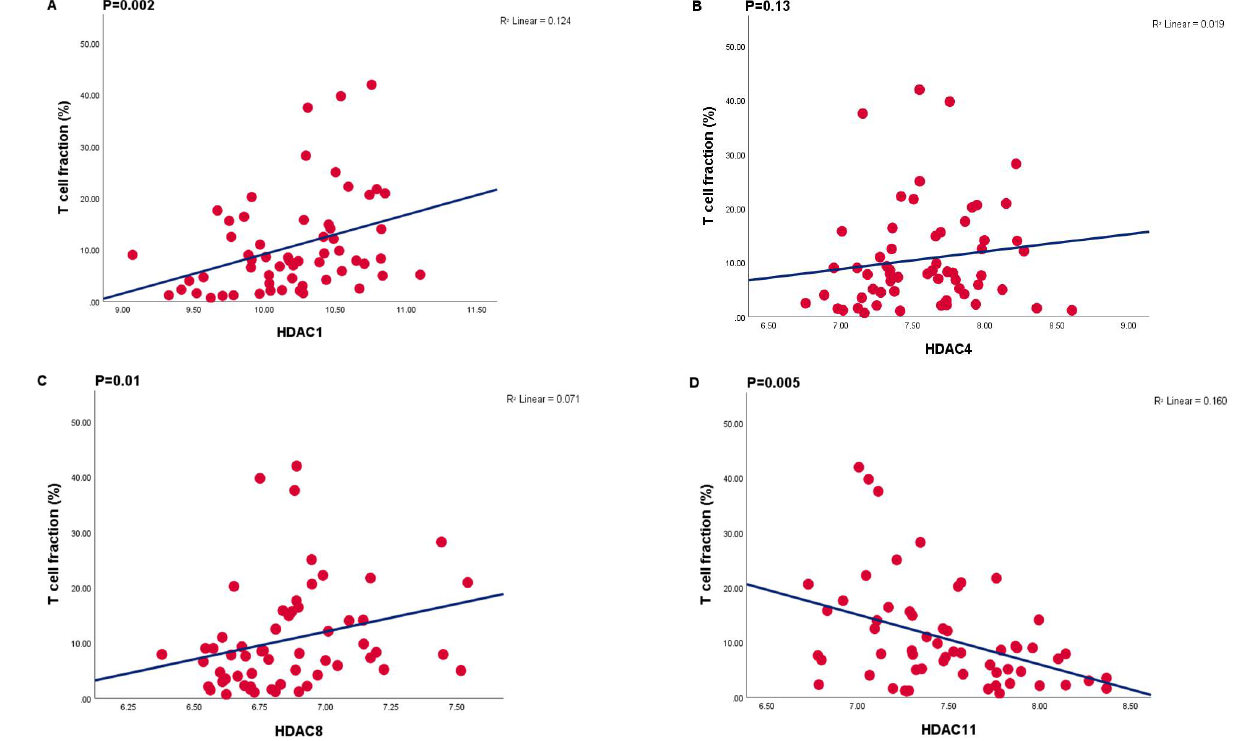
Figure 2. Correlations between mRNA expression levels (determined by Illumina array) of different HDACs and T cell fraction (%) (Determined by ddPCR) ( n = 59). ( A ) HDAC1 R2 = 0.124, p = 0.002, ( B ) HDAC4 R2 = 0.019, p = 0.13, ( C ) HDAC8 R2 = 0.071, p = 0.01, ( D ) HDAC11 R2 = 0.160, p = 0.005.